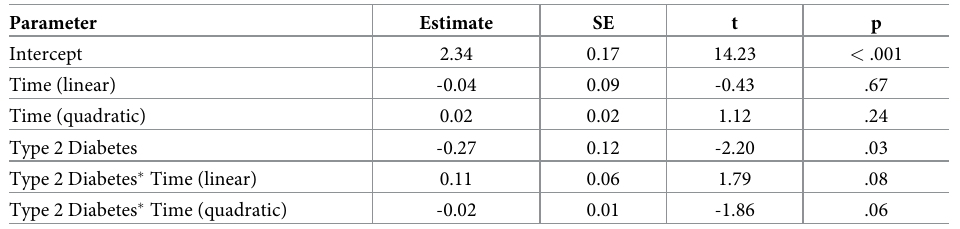
Table 4. Multilevel model on log(LF HRV): Estimates of fixed effects.